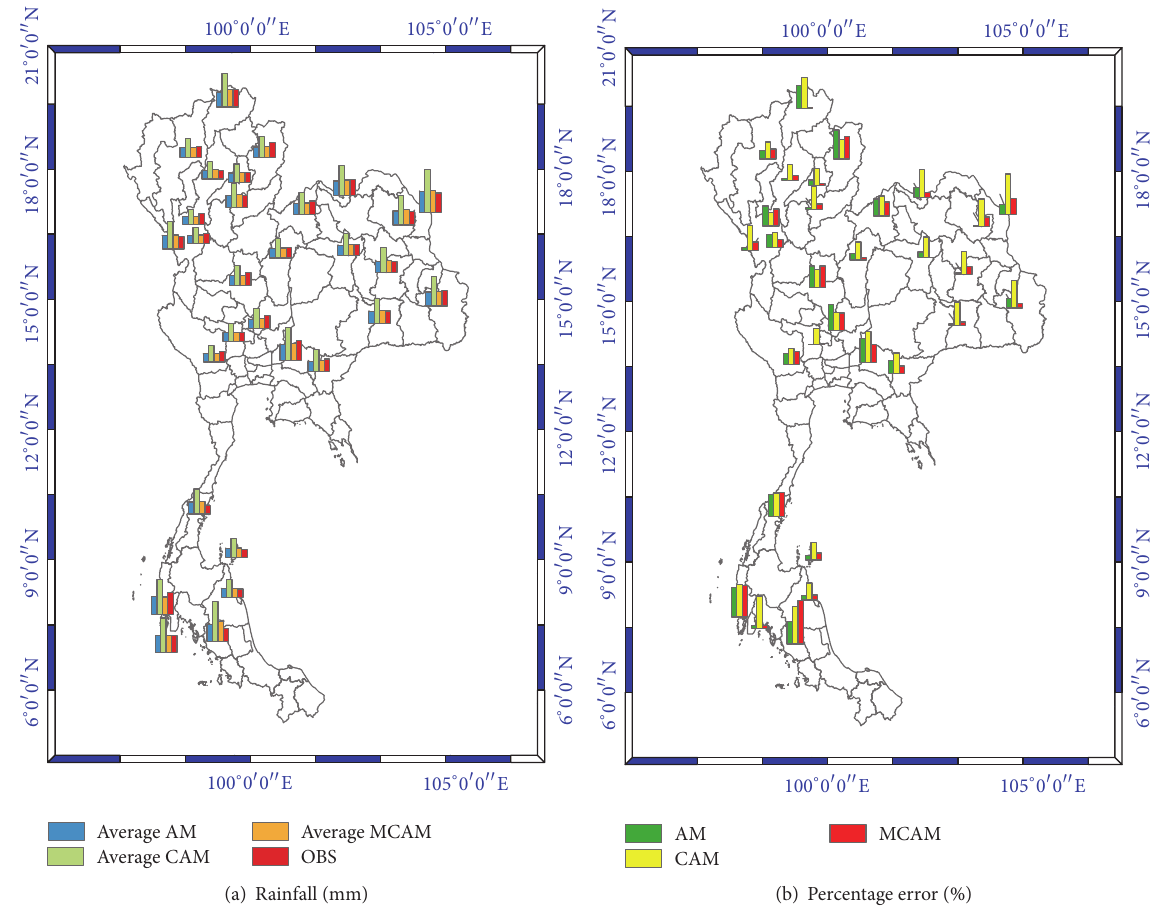
Figure 15: (a) shows the bar graphs for rainfall in millimeters as follows: the average forecasted rainfall by using the AM (blue), the average forecasted rainfall by using the CAM (green), the average forecasted rainfall by using the MCAM (orange), and the actual observed rainfall (red). (b) shows the bar graphs of percentage errors for each of the methods as follows: AM in green, CAM in yellow, and MCAM in red.